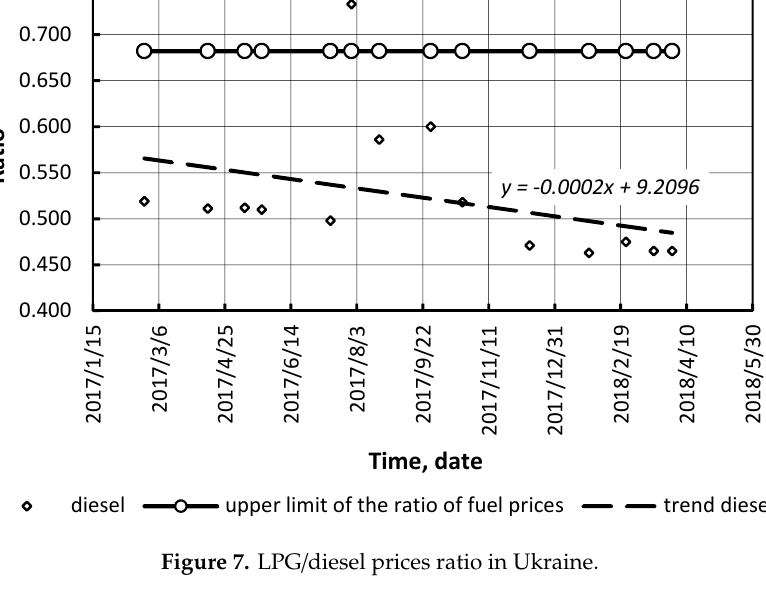
Figure 7. LPG/diesel prices ratio in Ukraine.